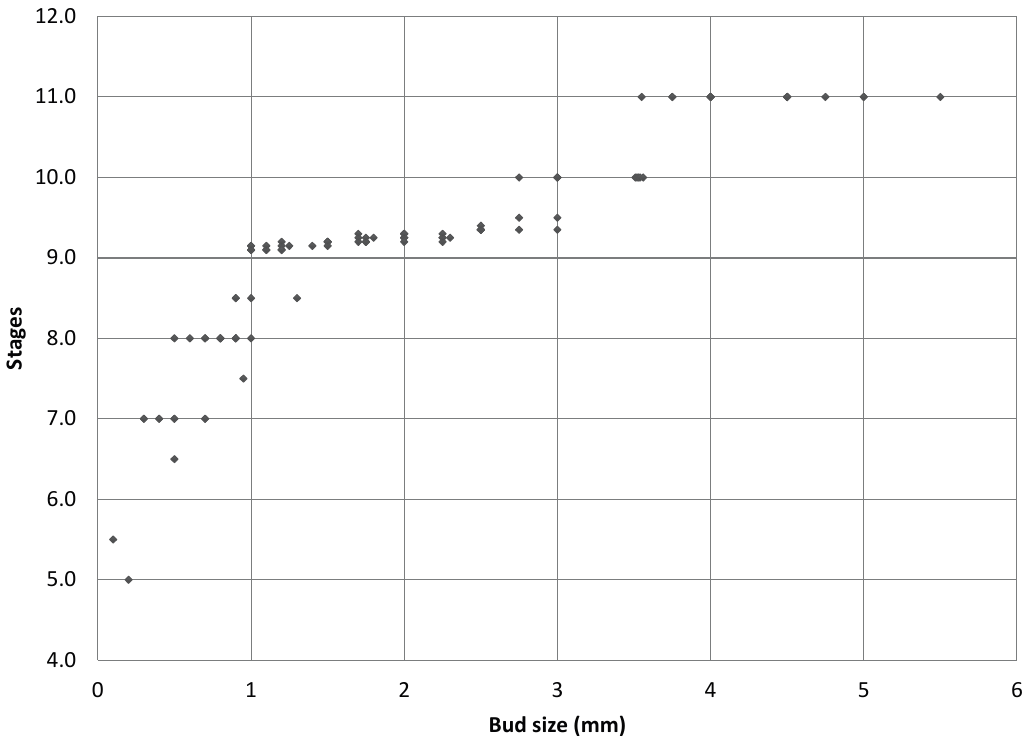
Figure 5. Scatterplot of the external and internal anther sizes of the infected and uninfected floral buds against the size of the floral buds. Ellipsoids indicate the range in bud sizes for flowers of the respective developmental stage groups indicated.